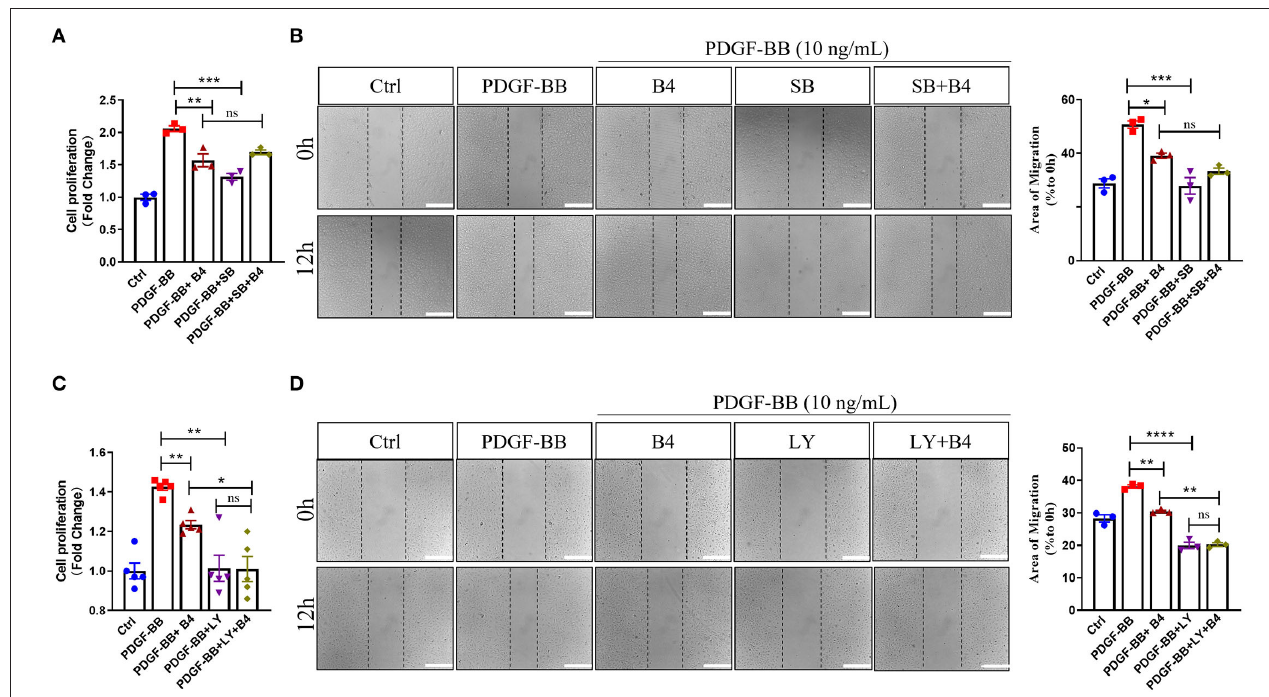
FIGURE 6 | B4 inhibits cell proliferation and migration by targeting the p38 MAPK and PI3K/Akt signaling pathways in VSMC. Quiescent MVSMCs were treated with B4 (20 µ M) for 24h and incubated with SB203580 (20 µ M) or SB203580 and B4 in the presence or absence of PDGF-BB for 48h. (A) Cell proliferation was quantified as a fold increase of control. (B) Cell migration was quantified as the percentage of the area of migrated cells covered area relative to time 0. Quiescent MVSMCs were treated with B4 (20 µ M) for 24h and incubated with LY294002 (10 µ M) or LY294002 and B4 in the presence or absence of PDGF-BB for 48h. (C) Cell proliferation was quantified as a fold increase of control. (D) Cell migration was quantified as the percentage of the area of migrated cells covered area relative to time 0. Data shown are means ± SEM. * P < 0.05; ** P < 0.01; *** P < 0.001 compared with PDGF-BB control group. All experiments were repeated for at least three